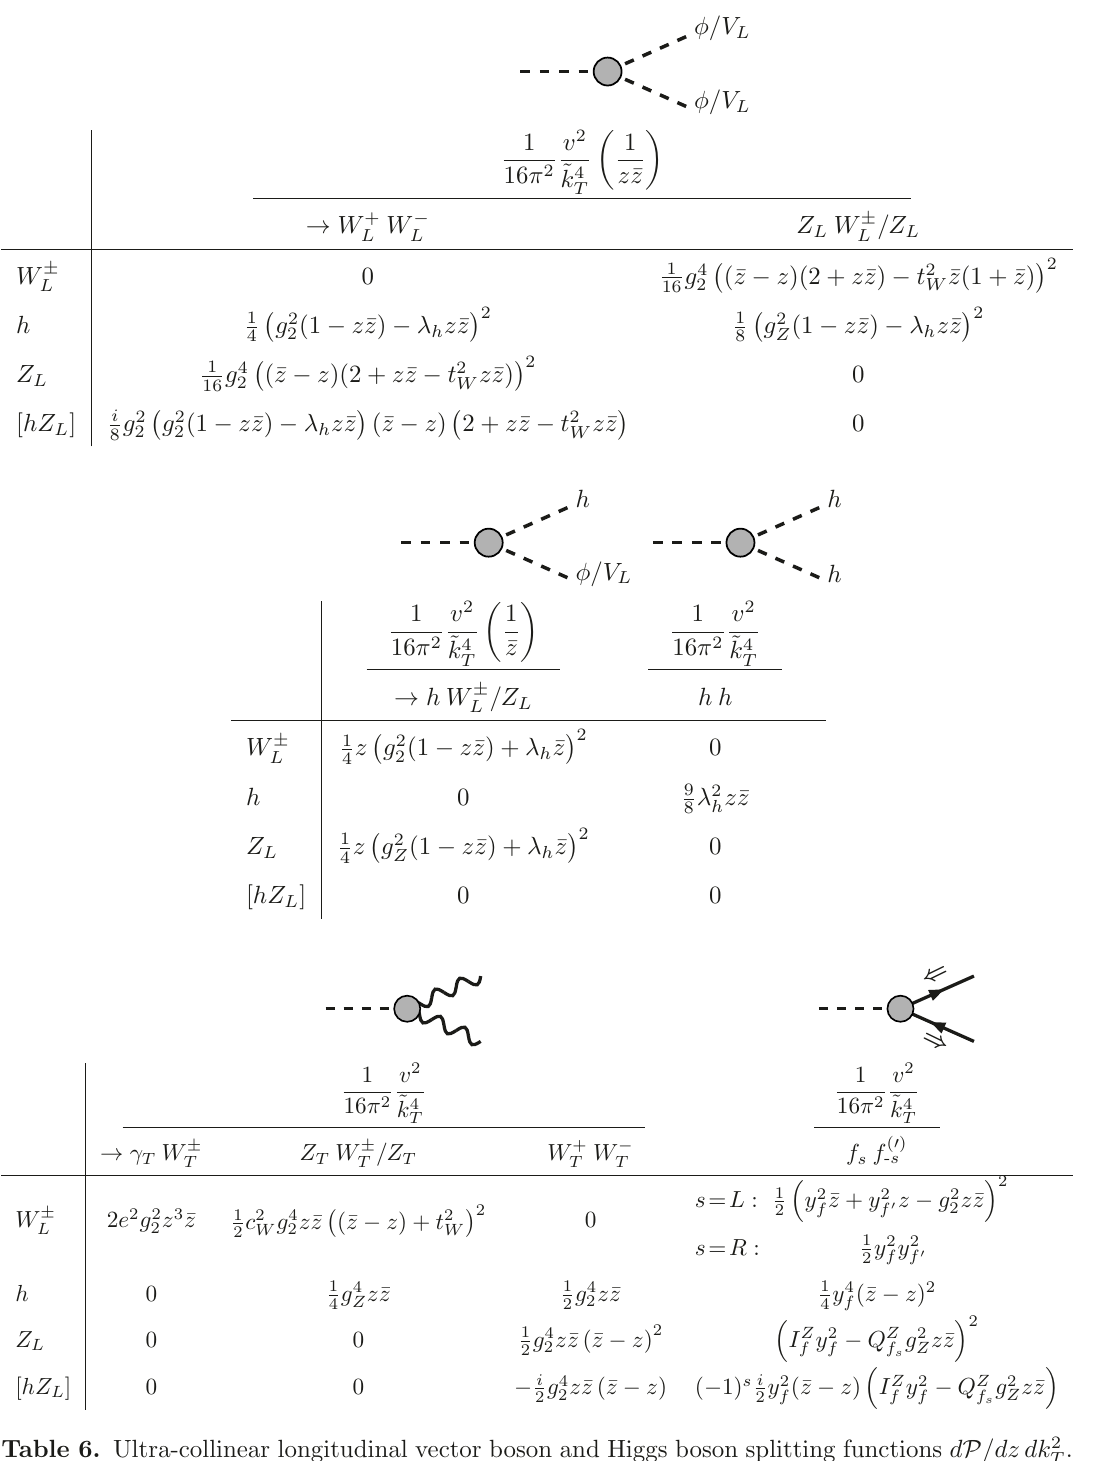
/dz dk 2 . T P = λ h v 2 / 2. For the off-diagonal incoming h + ¯ zm 2 + zm 2 z ¯ zm 2 ) ( k 2 + ¯ zm 2 + zm 2 z ¯ zm 2 ). Other T B C − T B C − Z h ·